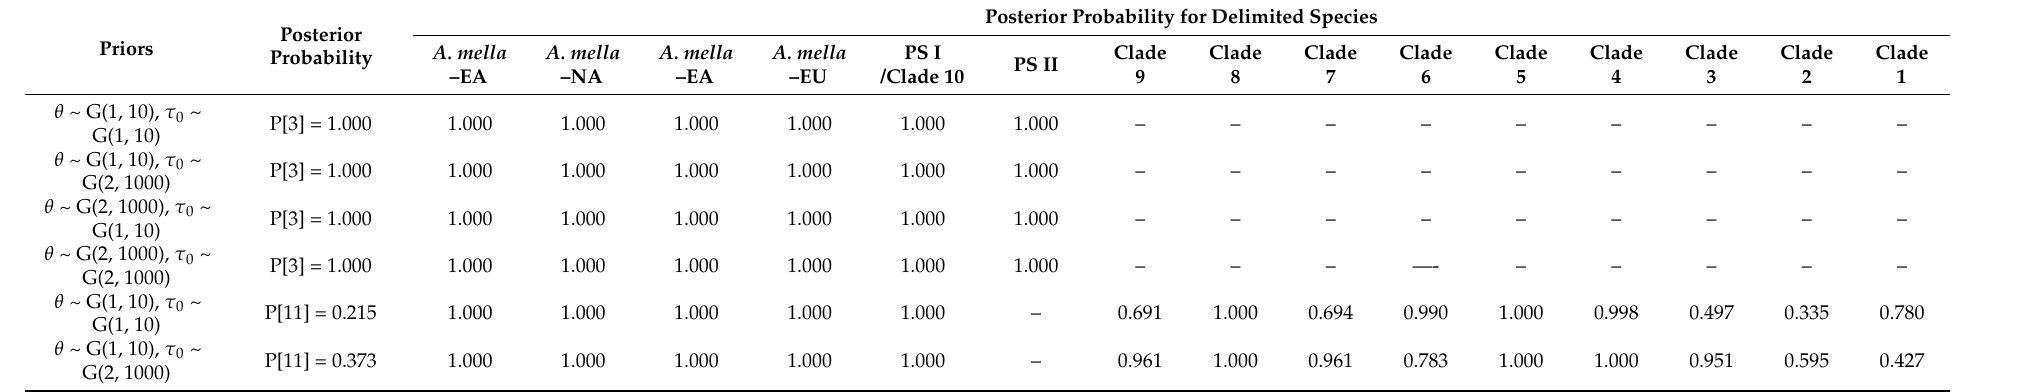
Table 1. Results from BPP analyses for the Gallica superclade assuming 3-species or 11-species models.